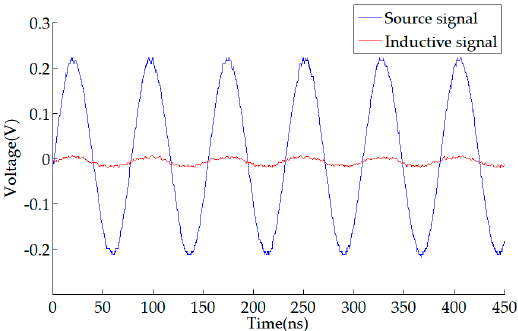
Figure 15. Output signal of the waveform generator and induced signal of the D-HFCT sensor.